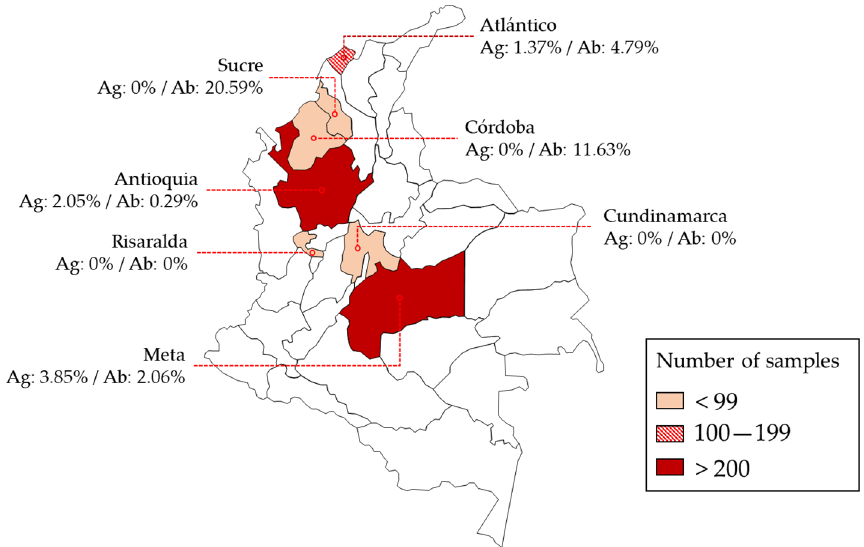
Figure 2. Geographical origins of domestic dogs ( n = 955) serologically examined for Angiostrongylus vasorum occurrence. Different red shades represent the sampling density by area. Ag: antigen prevalence; Ab: antibody prevalence.